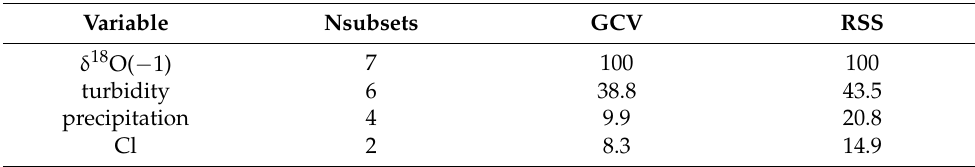
Table 8. The contributions of various independent variables in the MARS model.